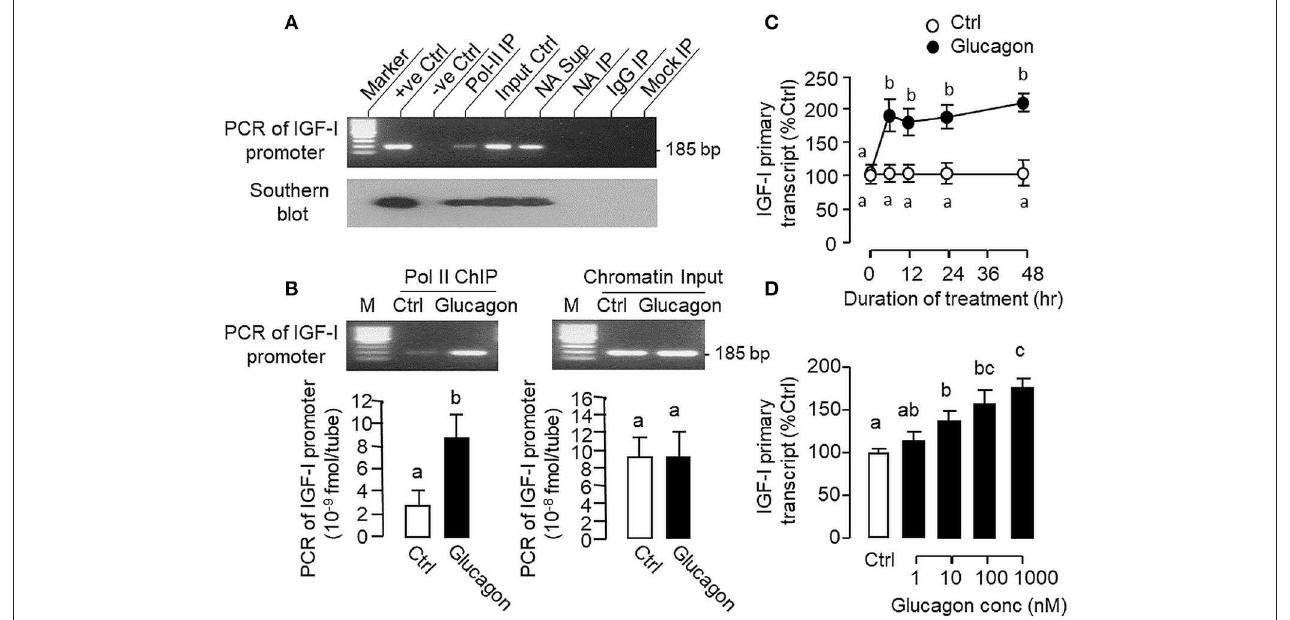
FIGURE 10 | Glucagon-induced Pol-II recruitment to IGF-I promoter and production of IGF-I primary transcript in carp hepatocytes. (A) Pol-II binding with IGF-I promoter revealed by PCR coupled with chromatin immunoprecipitation (ChIP). Chromatin samples with fragment size of 0.5–0.8kb after sonication were prepared from carp hepatocytes and used for ChIP with the antibody for RNA Po-II (as “Pol-II IP”). After decrosslinking, PCR was performed using primers covering the proximal region of the carp IGF-I promoter. In this experiment, genomic DNA (as “ + ve Ctrl”), chromatin input (as “Input Ctrl”) and “supernatant” of chromatin sample after IP with no antibody (as “NA Sup”) were used as the positive control. PCR without adding the template (as “–ve Ctrl”) or with chromatin samples after IP with “No Antibody” (as “NA IP”)/parallel ChIP with antibody for mouse IgG (as “IgG IP”) or without chromatin input (as “Mock IP”) were used as the negative control. The authenticity of PCR products detected was also confirmed with Southern blot using a DIG-labeled probe covering the same region of the IGF-I promoter. (B) Glucagon-induced Pol-II recruitment to IGF-I promoter in carp hepatocytes. Hepatocytes were challenged for 1h with glucagon (10nM) and subjected to chromatin preparation followed by ChIP with Pol-II antibody. After that, real-time PCR with primers covering the proximal region of IGF-I promoter was performed for quantitation of IGF-I promoter pulled down with RNA Pol-II. Real-time PCR for IGF-I promoter was also conducted in the chromatin input prior to Pol-II ChIP to serve as the loading control. (C) Time course and (D) Dose dependence of glucagon treatment on IGF-I primary transcript expression in carp hepatocytes. For the time course experiment, the dose of glucagon used was fixed at 100nM for the duration as indicated, while the duration of drug treatment was fixed at 12h for the dose-response study. After that, total RNA was isolated, digested with DNase I to remove genomic DNA contamination, and subjected to real-time PCR using primers covering the junction of exon III and intron III of carp IGF-I